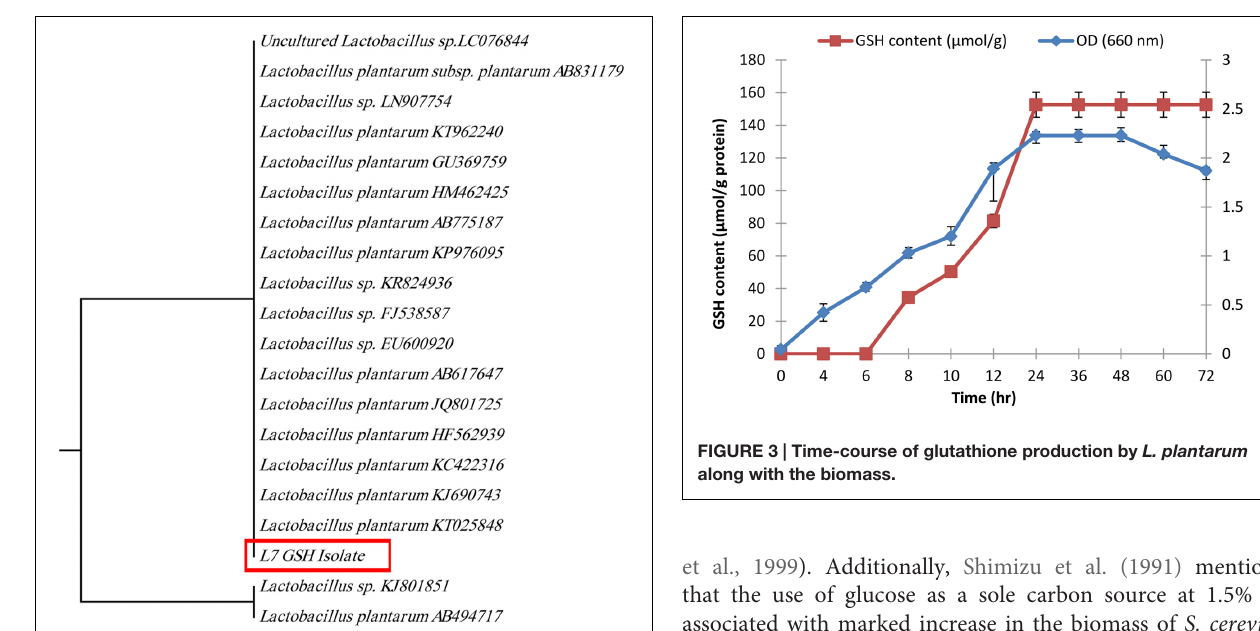
et al., 1999). Additionally, Shimizu et al. (1991)